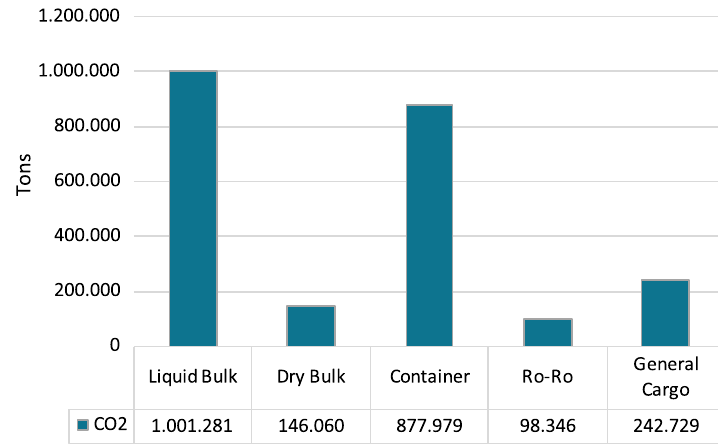
Fig. 4 Emissions of CO 2 . Maritime transport in